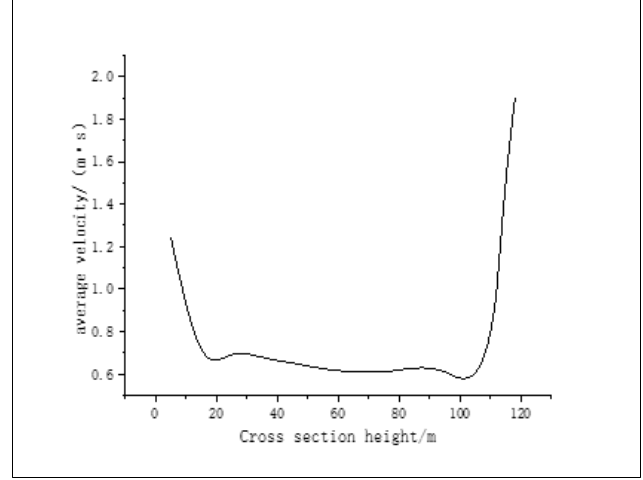
Figure 9. Average air velocity at different cross-sectional heights.